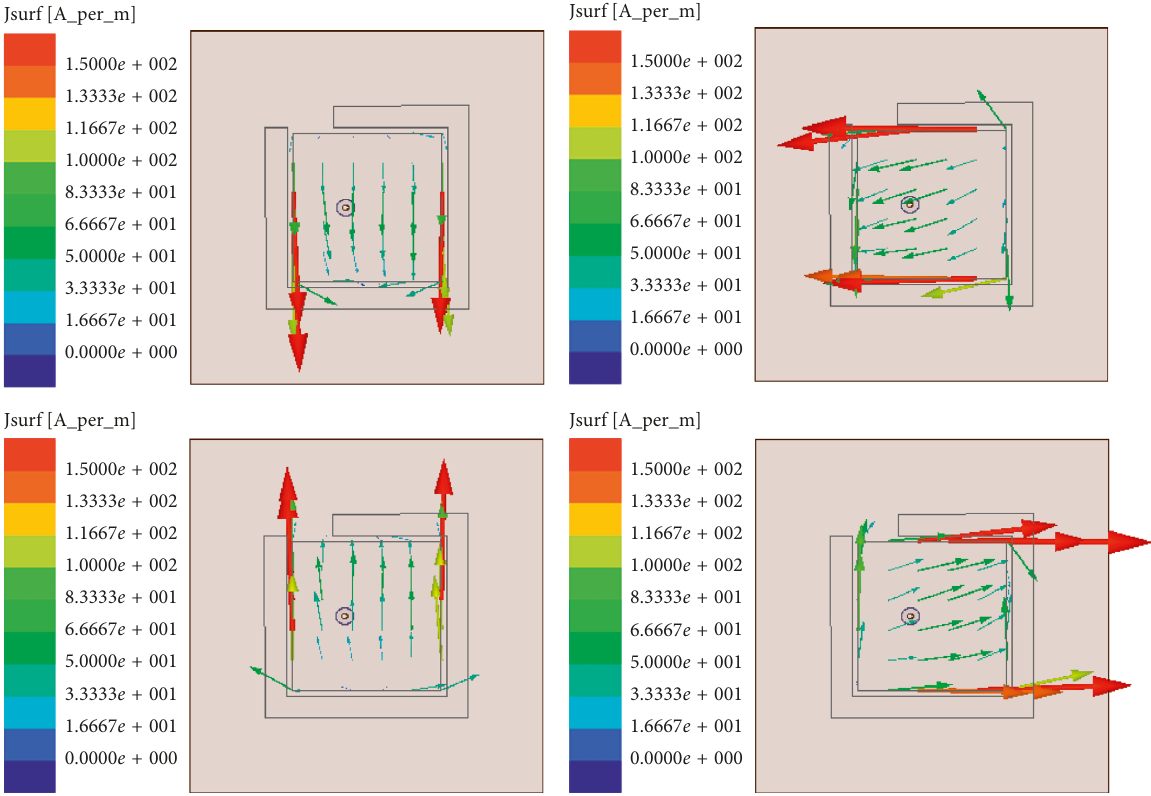
Figure 2: The surface current distribution on the LHCP antenna radiated patch at